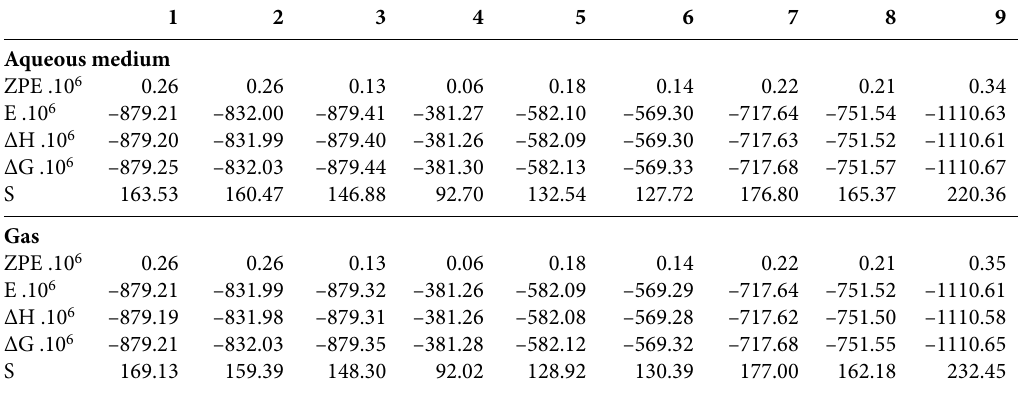
Table 2. Calculated energies and thermodynamic parameters of drugs. ZPE, E, ΔH, ΔG (in cal.mol –1 ), S (in cal mol –1 K –1